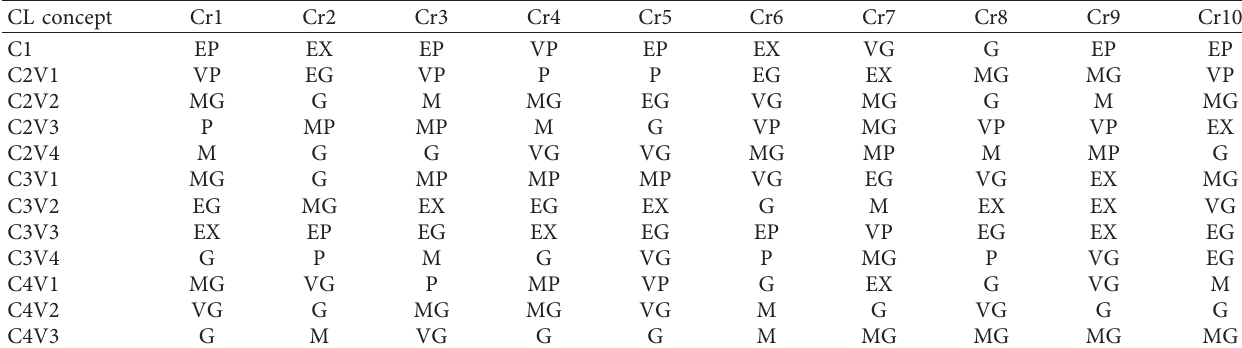
Table 4: Drone-based CL concepts evaluation according to the